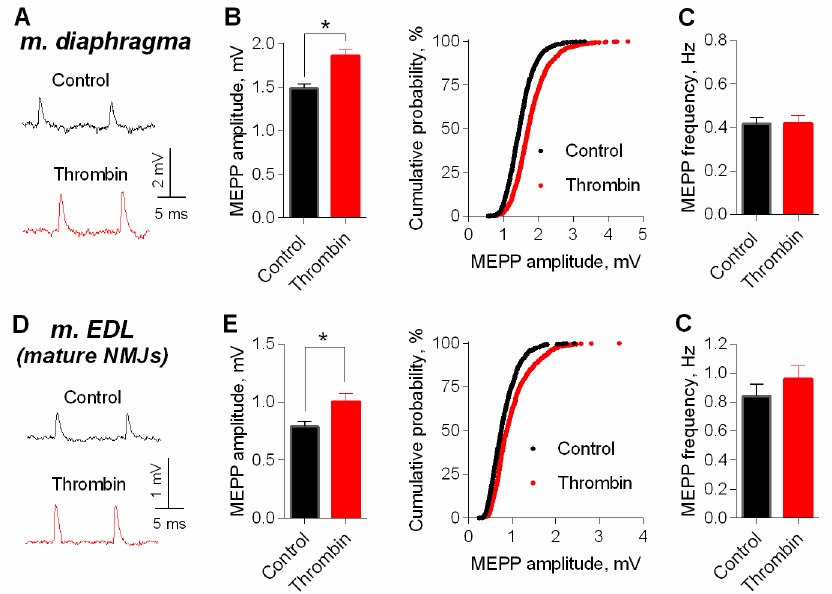
Figure 3. Thrombin-induced potentiation of spontaneous ACh release at mature NMJs. ( A ) Representative recordings of MEPPs in diaphragm in control (above) and upon application of thrombin (1 nM) (below). ( B ) Mean amplitude of MEPPs (left) and cumulative probability plots (right) in control ( n = 24) and upon application of thrombin ( n = 32). ( C ) Mean frequency of MEPPs in control and in the presence of thrombin. ( D ) Representative recordings of MEPPs in m. EDL in control (above) and upon application of thrombin (1 nM) (below). ( E ) Mean amplitude of MEPPs (left) and cumulative probability plots (right) in control ( n = 28) and upon application of thrombin ( n = 31). ( F ) Mean frequency of MEPPs in control and in the presence of thrombin. Histograms and error bars represent the mean ± SEM. * p < 0.05 compared to control.